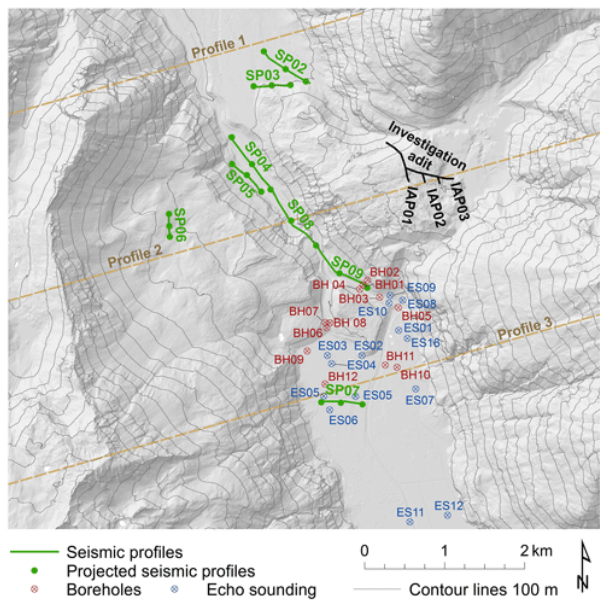
Figure 3. Borehole data (BH), echo soundings (ESs) and seismic profiles (SPs) used for the topographic reconstruction of the Köfels